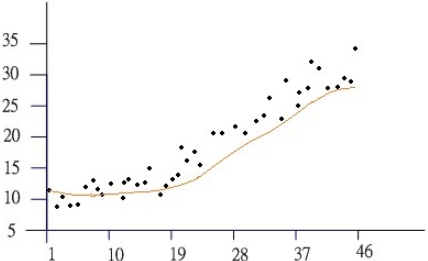
Figure 1. Exponential smoothing ( α = 0.2).